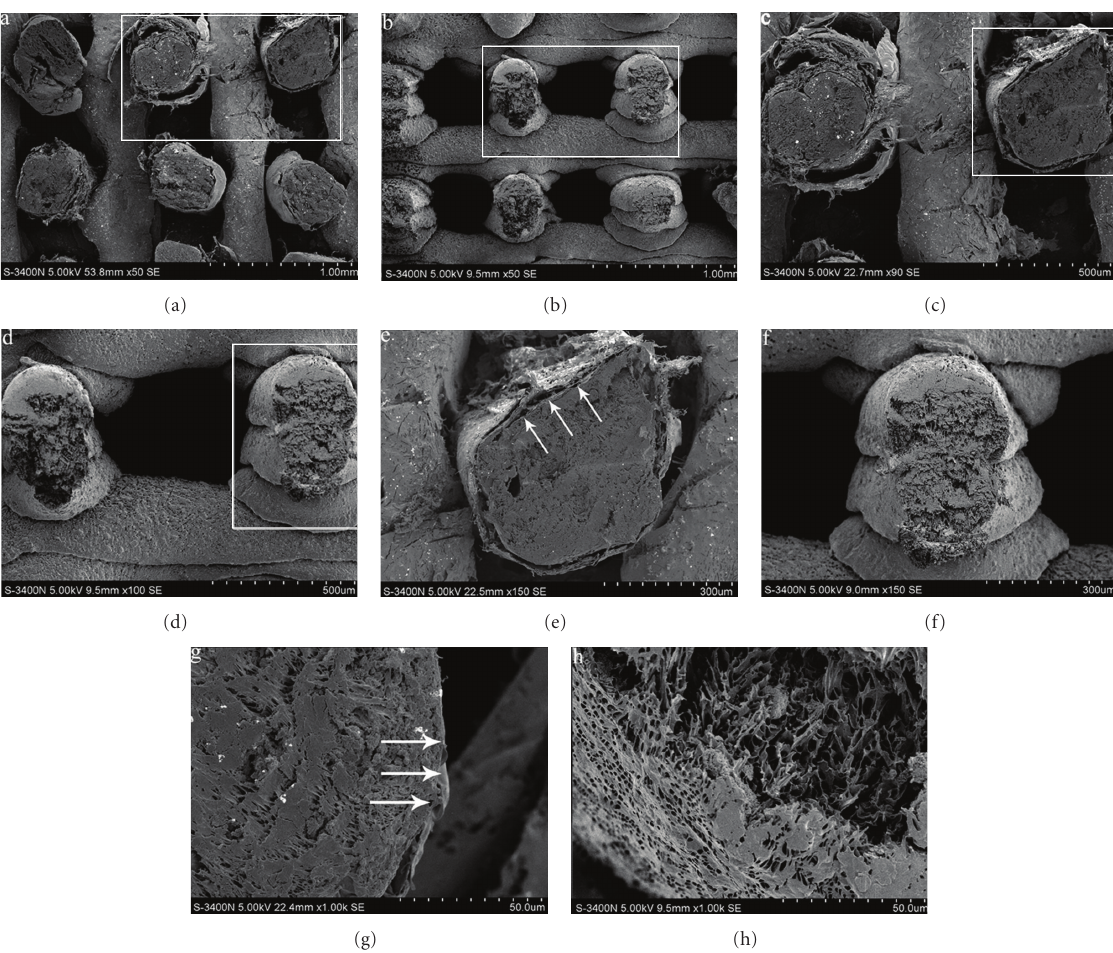
Figure 1: (a and b) Morphological comparison observation by SEM of the core-sheath structure composite sca ff old and the PLGA/ β -TCP skeleton ( × 50,50). (c and e) Magnified view of the white rectangle frame from (a) ( × 90,150). Note: the arrows point to the collagen wrapped the PLGA/ β -TCP. (d and f) Magnified view of the white rectangle frame from (b) ( × 100,150). (g) Morphological observation by SEM of the core-sheath structure composite sca ff old ( × 1 k). Note: the arrows point to the interface of the PLGA/ β -TCP and the collagen. (h) Morphological observation by SEM of the PLGA/ β -TCP skeleton. ( × 1k).